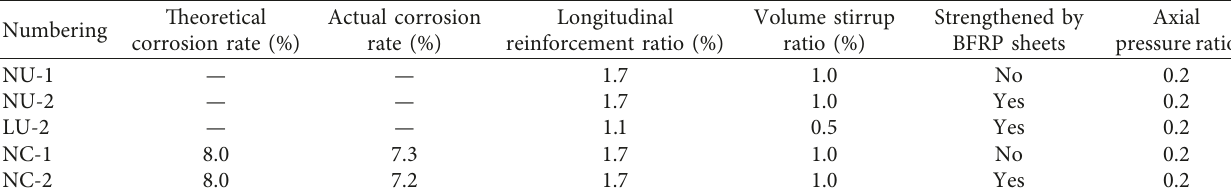
Figure 1: Details of specimens: (a) standard reinforcement ratio; (b) low reinforcement ratio (unit: Table 2: Design parameters of specimens.